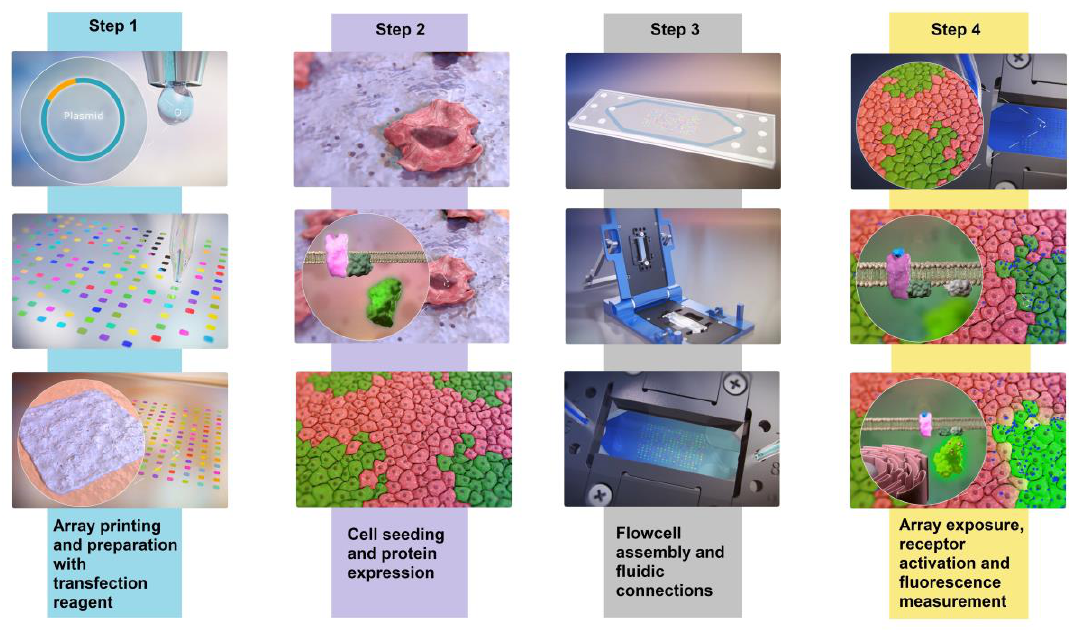
Figure 1. Schematic overview of array preparation and measurement in the microfluidic system. Steps 1 and 2 show array preparation involving DNA spot contact printing, overlay with transfection reagent, subsequent seeding of cells and expression of DNA after cell division. Step 3 shows the assembly of the flowcell and placement into the Micronit FluidConnect Pro flowcell holder. Once the holder is closed, fluidic connections are established, and the microfluidic system produces a pressure-controlled flow. Specific volumes of samples are injected sequentially into the constant flow to stimulate cell responses on the micro array (Step 4). Continuously, the entire array within the flowcell is imaged to capture the fluorescence from the calcium indicator YC3.6 over time and allow high-throughput screening. See also Supplementary Materials Video S1 and Figure S1.